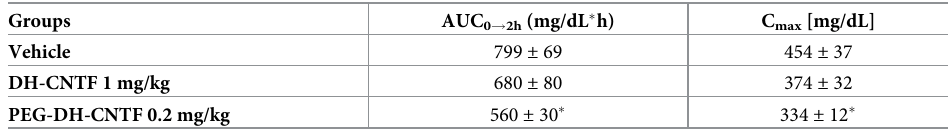
Table 5. Area under the curve (AUC) and C max in glucose tolerance